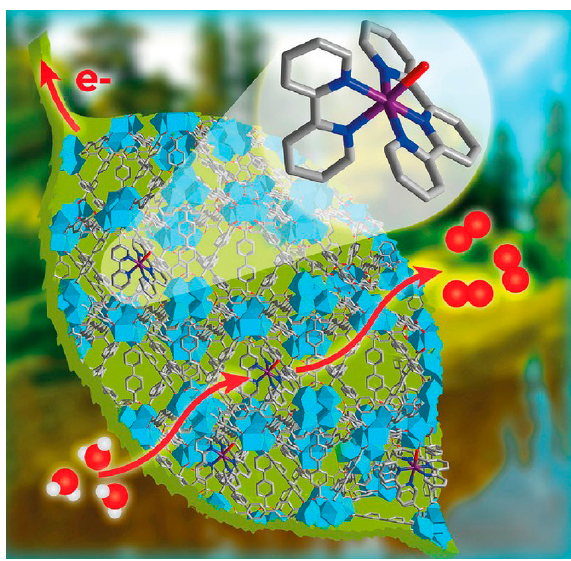
Figure 6. The use of a Zr-MOF (metal–organic framework) incorporated with ruthenium-based complex for electrocatalytic oxygen evolution [41]. Reproduced with permission from [41], Copyright John Wiley and Sons, 2017.